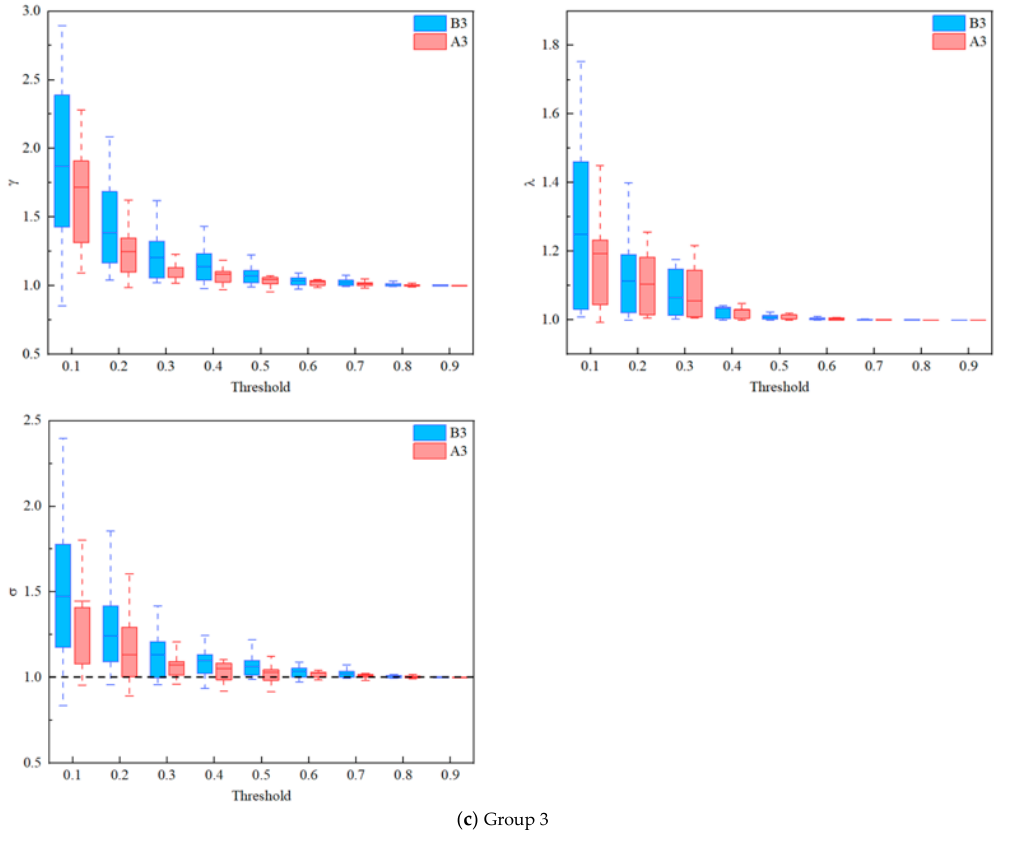
Figure 6. Comparison of the brain network among 3 shifts coal mine workers between before and after shift work: small worldness ( γ , λ , σ ). ( a ) Group 1. ( b ) Group 2. ( c ) Group 3. The oxy-Hb-based group differences in betweenness centrality and nodal local efficiency during the resting state were available in Tables 4 and 5, provided with a paired t -test ( p < 0.05). The results showed that there were significant differences between before Table 4. Group differences in betweenness centrality during resting and after work shifts in group 1 and group 3, while there were no differences before and after work shifts in group 2 ( p < 0.05). In particular, CH15 (belong to FPC) passed the paired t -test in betweenness centrality in group 1 ( p = 0.0483) and CH19 (belong to OFC) in group 3 ( p = 0.039). Further, CH18 (belong to dlPFC) passed the paired t -test in nodal local efficiency in group 1 ( p = 0.0395) and CH14 (belong to dlPFC) in group 3 ( p = 0.0475).